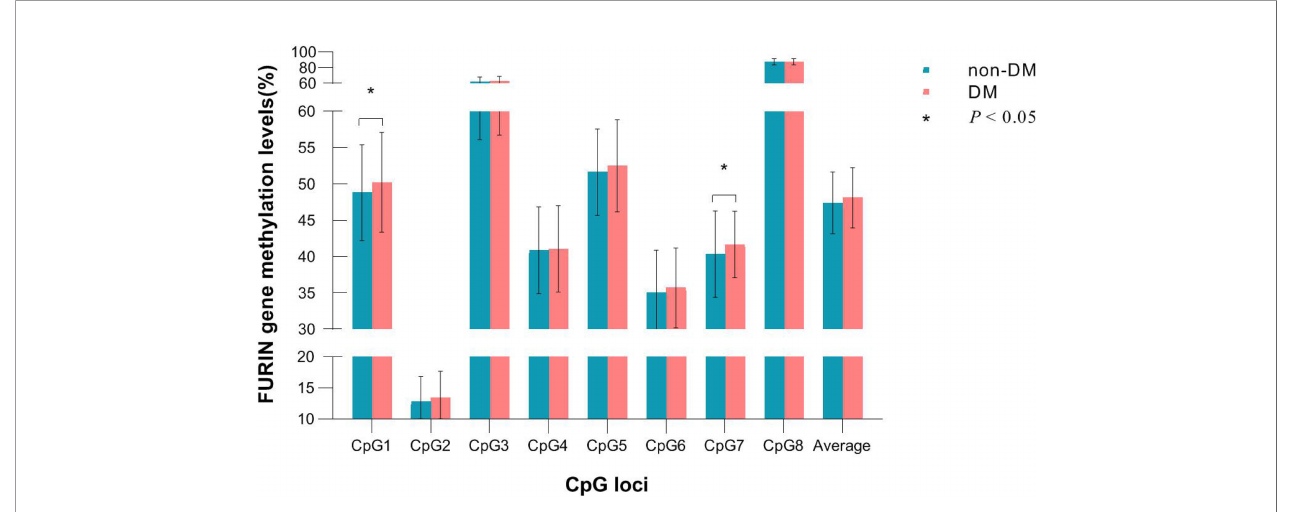
FIGURE 2 | DNA methylation levels of each CpG in participants who developed incident diabetes and those who did not during follow-up.